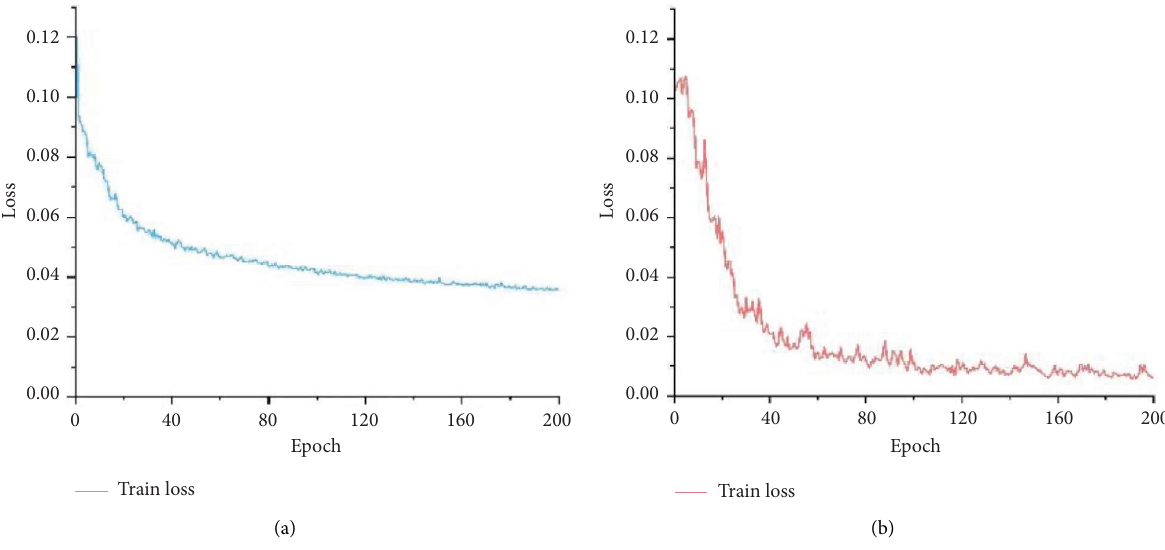
Figure 11: Training process of EDN-NPSP (200 epochs). (a) Training based on Loss